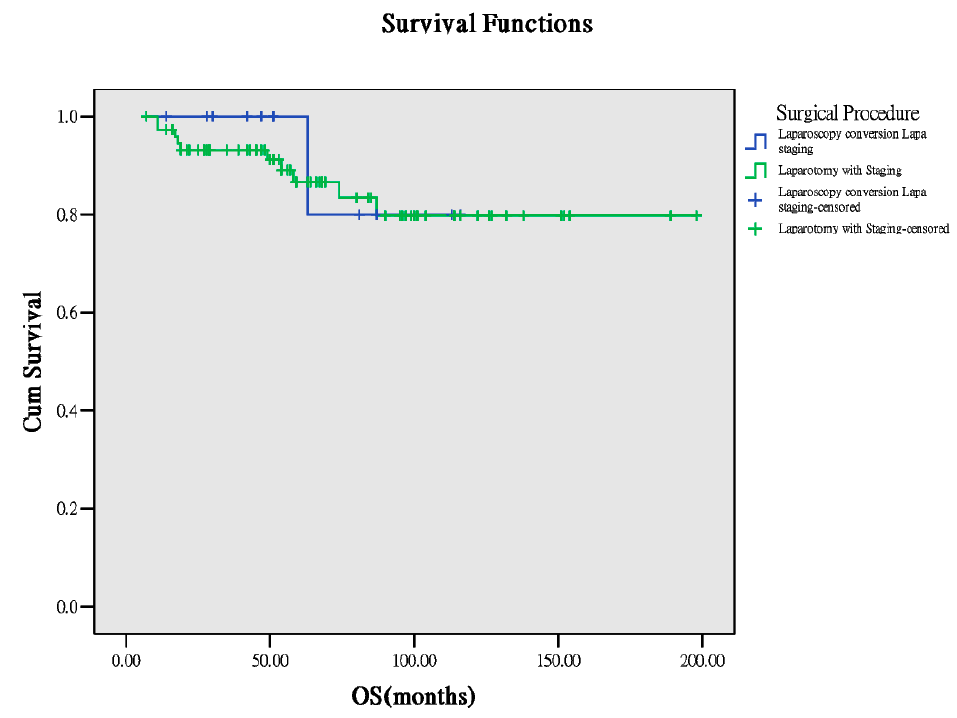
Figure 3. PFS between the surgical approaches ( p = 0.493).